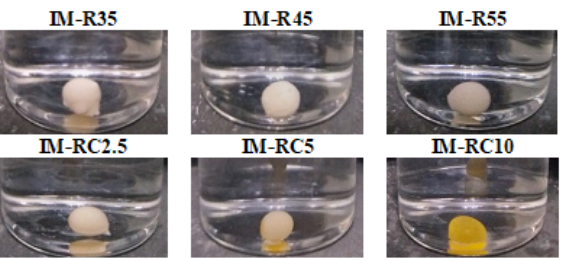
Figure 2. Gel formation of the IM-loaded rosin/CO-based ISG formulations after the injection of the formulations into the phosphate buffer pH 7.4.